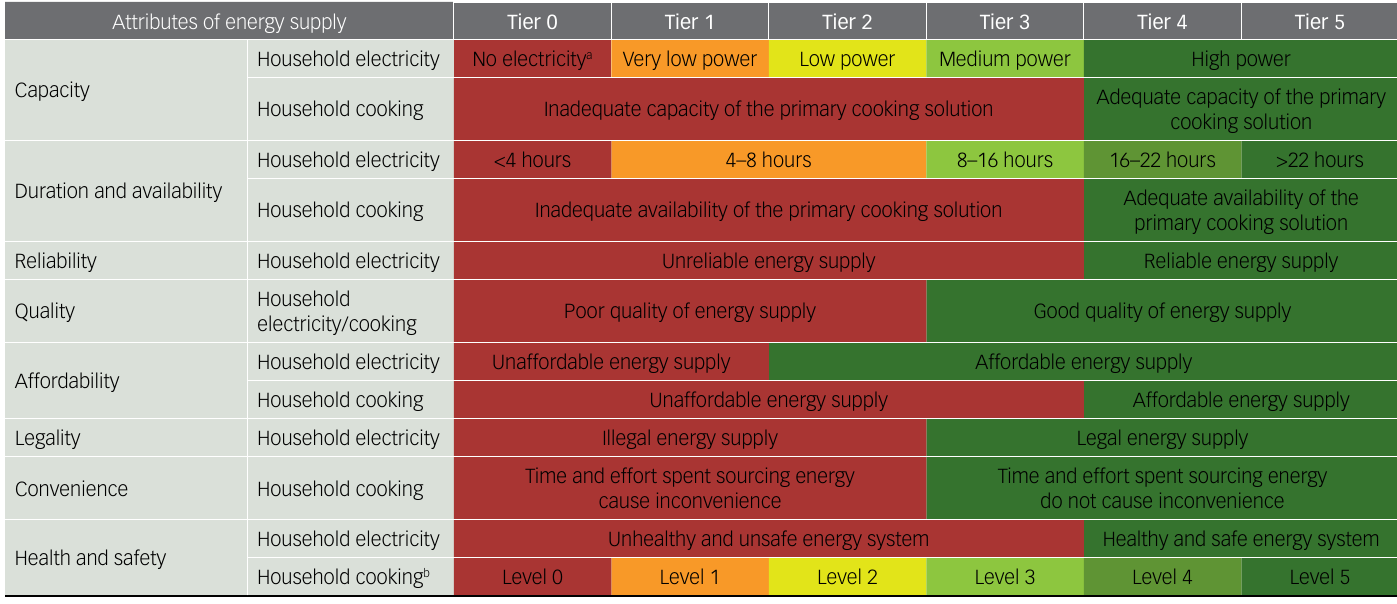
Table 1. Simplified multi-tier matrix of energy